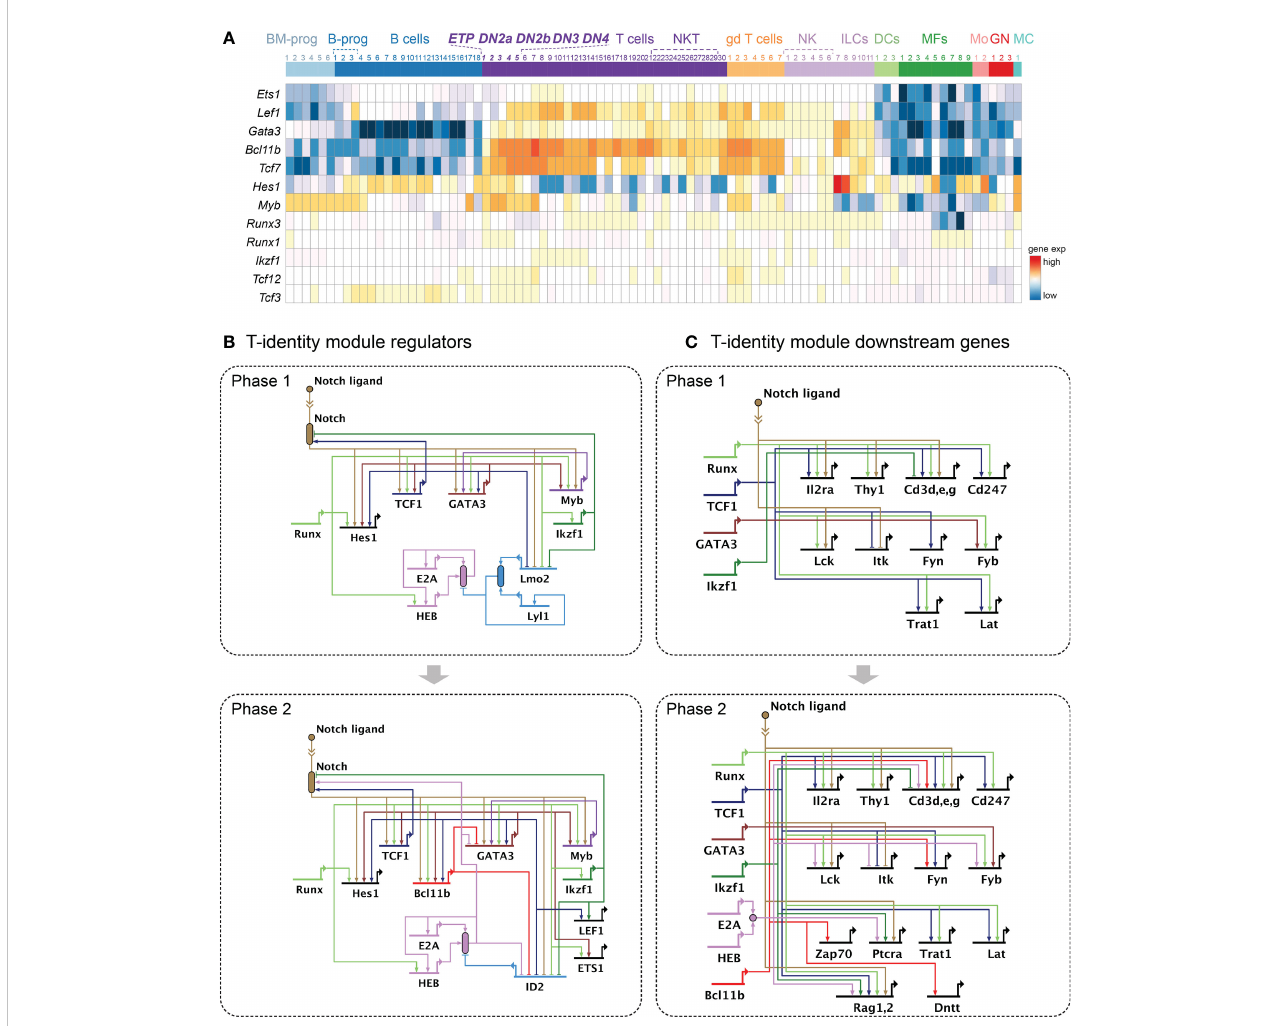
FIGURE 2 Gene regulatory networks driving the T-identity module. (A) Heatmap shows expression patterns of key transcription factors supporting the T-identity module across different immune cell types, using the ImmGen MyGeneSet tool (https://www.immgen.org) (93). Bone marrow progenitor (BM progen),